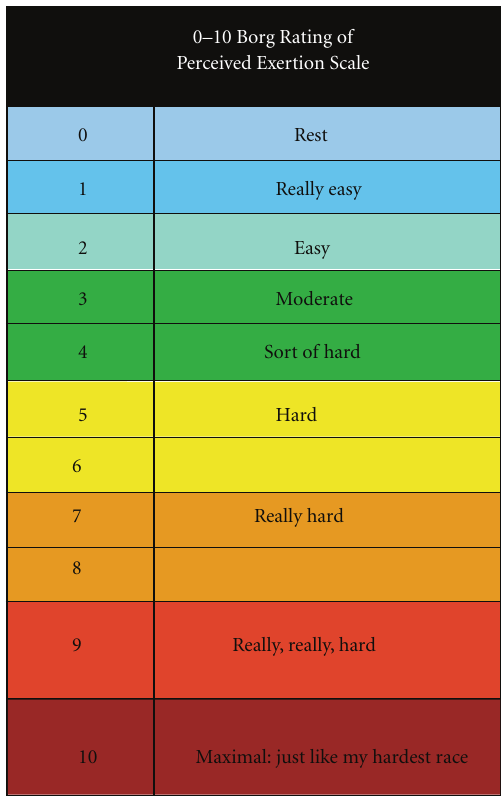
Figure 2: Borg exertion